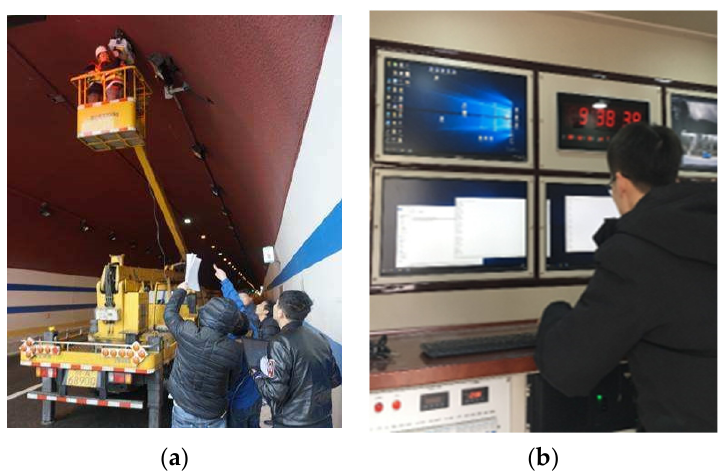
Figure 13. ( a )Traditional testing methods require inspectors to work on ascending equipment; ( b ) In the proposed method the inspector can stay in the vehicle to conduct the detection.